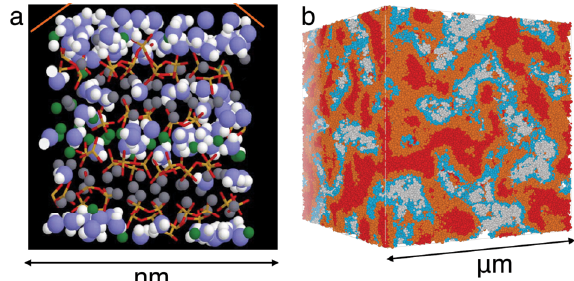
Figure 1: a) At the root of the bottom-up approach the first atomistic model of cement [1]. b) Up-scaling to the first meso- scale model of cement hydrates [2]. The color code of the meso-scale model indicates locally dense and loose regions of matter (the density increases from gray, blue, orange to